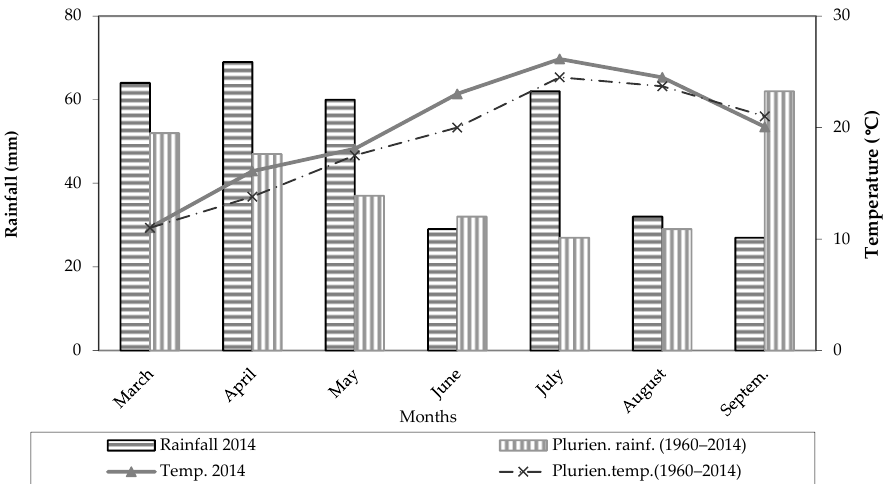
Figure 1. Monthly mean temperatures and total monthly rainfall during the maize cropping cycle for the study year and the long-term period (1960–2014).